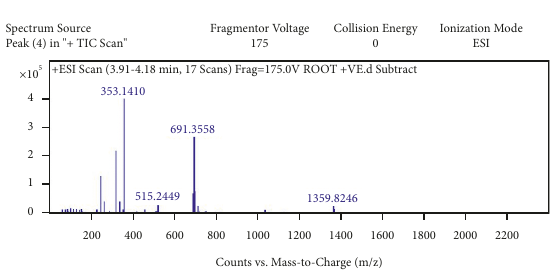
Figure 7: Mass spectra of peak 4.